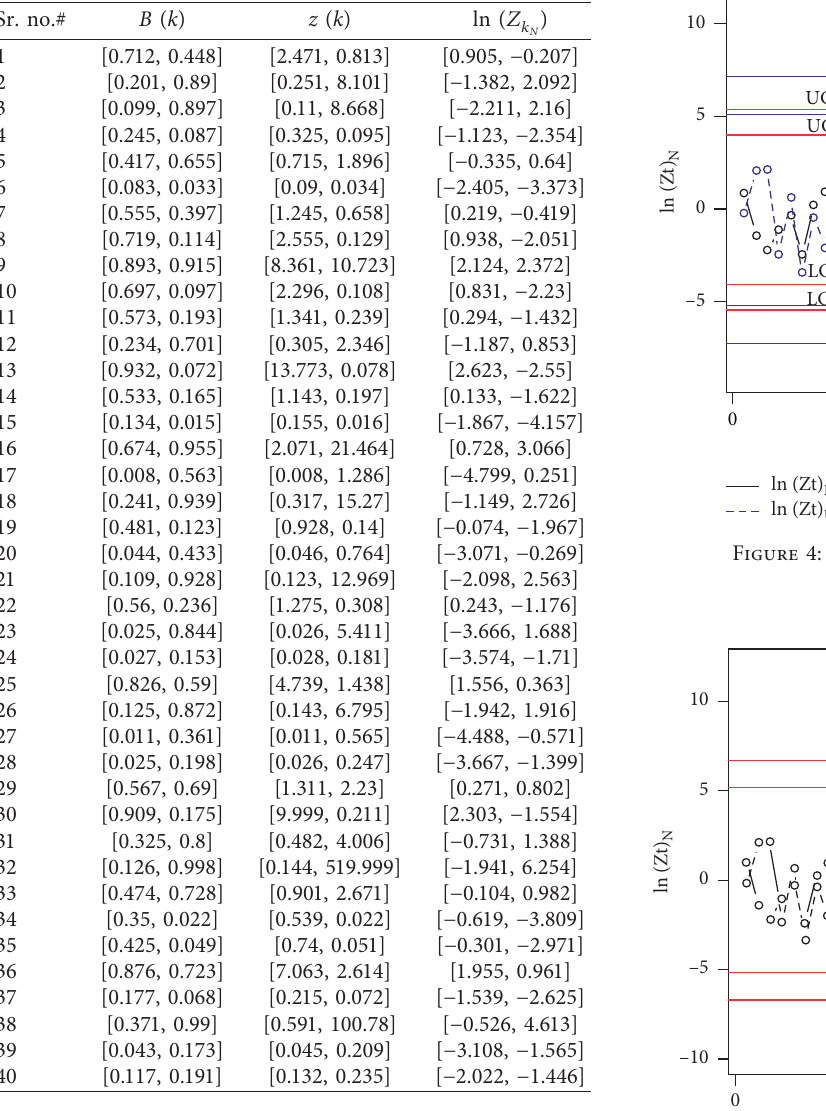
Table 8: The UTI data.